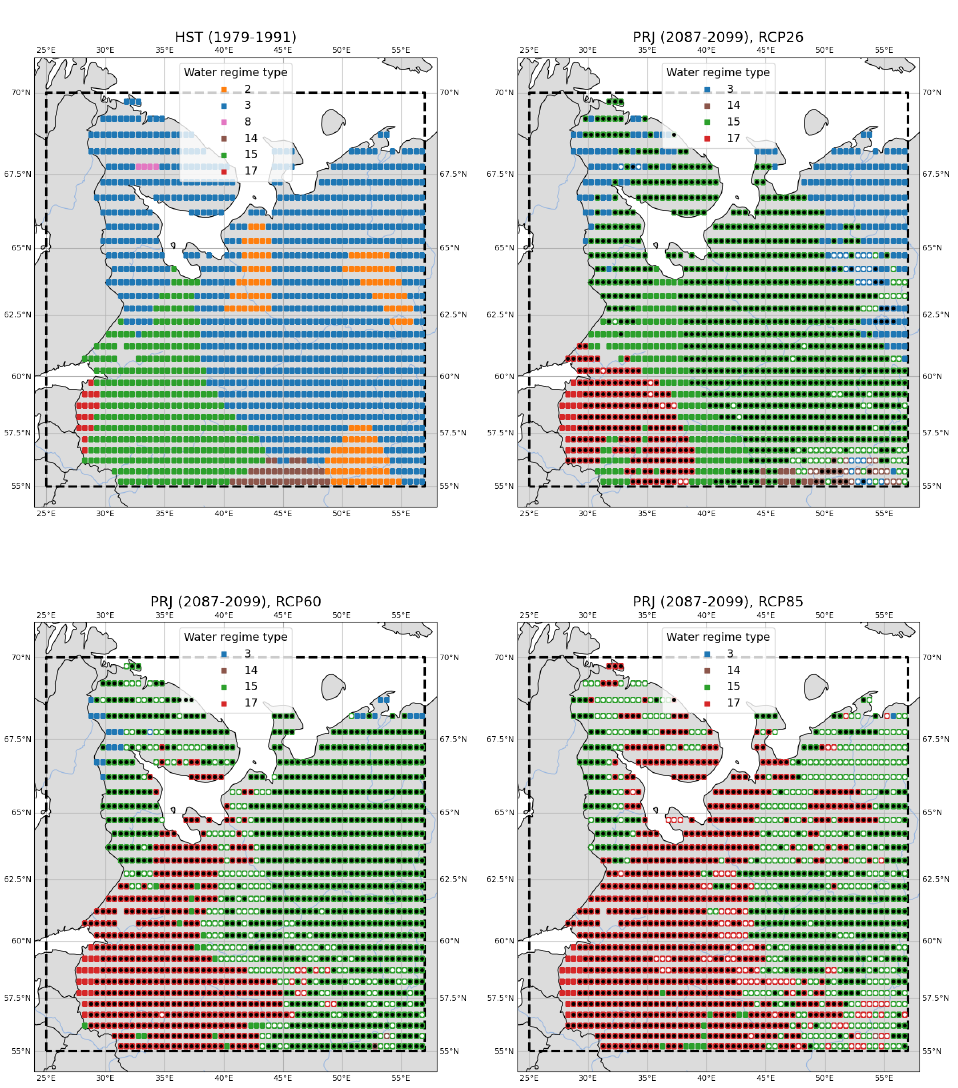
Figure 7. Historical (HST; 1979–1991) and projected (PRJ; 2087–2099) water regime types under different RCPs (RCP26, RCP60, RCP85). Black and white marks highlight high and low model confidence,